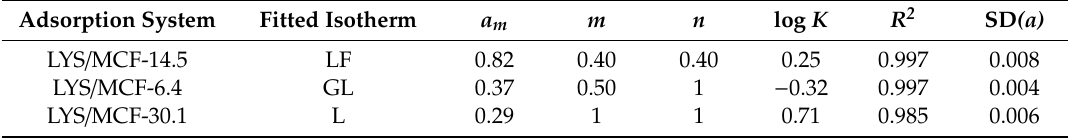
Table 2. Parameters of the Generalized Langmuir (GL) isotherm equation (optimized to (LF) Langmuir − Freundlich or (L) Langmuir Isotherms) characterizing the adsorption systems investigated.